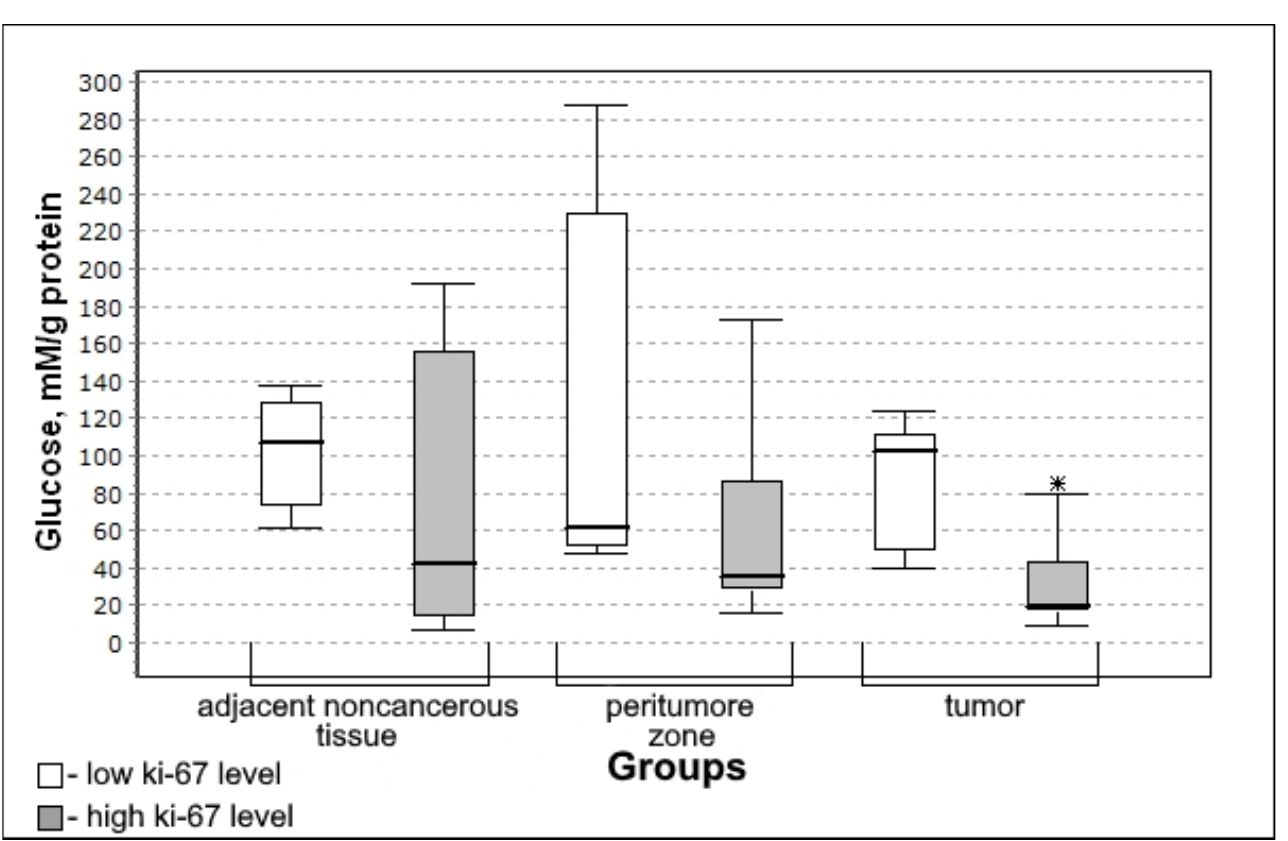
Figure 6. Medians and interqu artile ranges (IQR) of the content of glycogen synthase kinase 3β in glioma tissue depending on the magnitude of the mitotic index Ki-67 (low Ki-67 n = 7; high Ki-67 n = 13). Statistics are reported * p < 0.05.